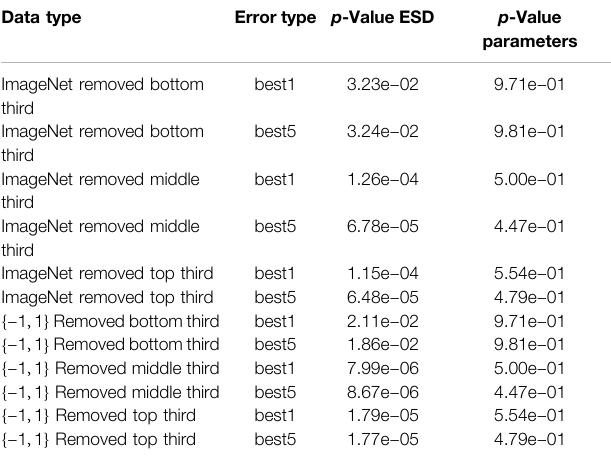
TABLE 4 | Comparison between the p -values for the number of parameters and ESD for predicting testing